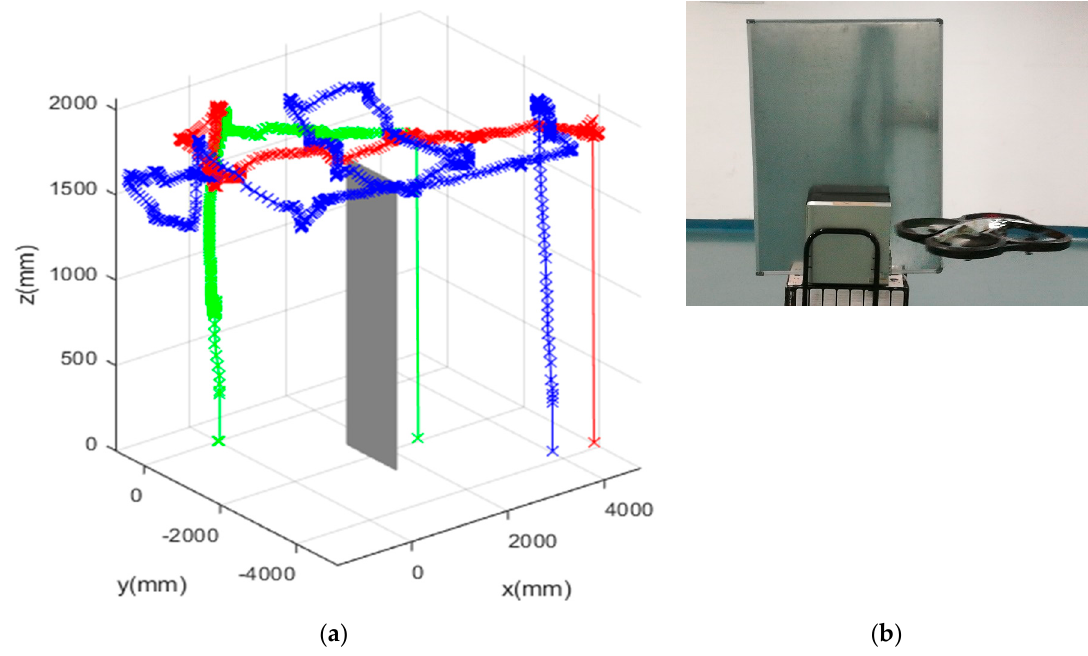
Figure 16. ( a ) PODA trajectory acquisition. ( b ) General Visual Inspection (GVI) application: flights around an aluminum plate.